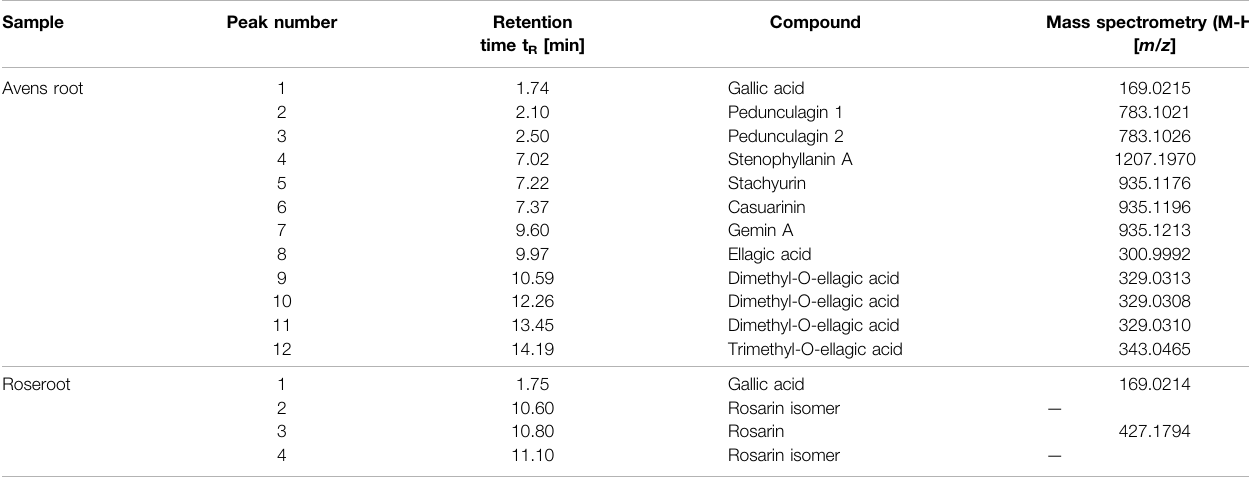
TABLE 3 | Identi fi cation of major compounds in root extracts using LC-MS analysis.